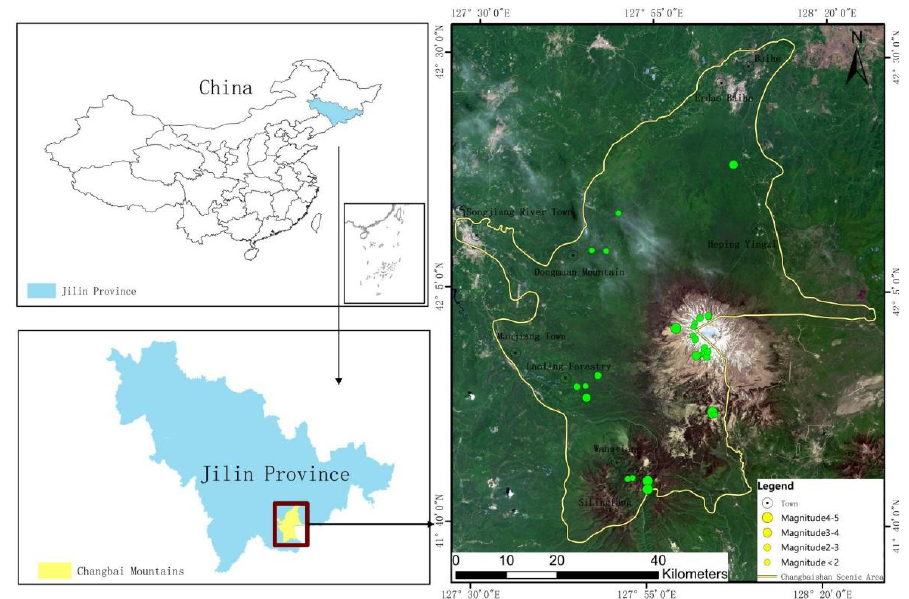
Figure 2. Location of the study area and distribution of seismic sites .